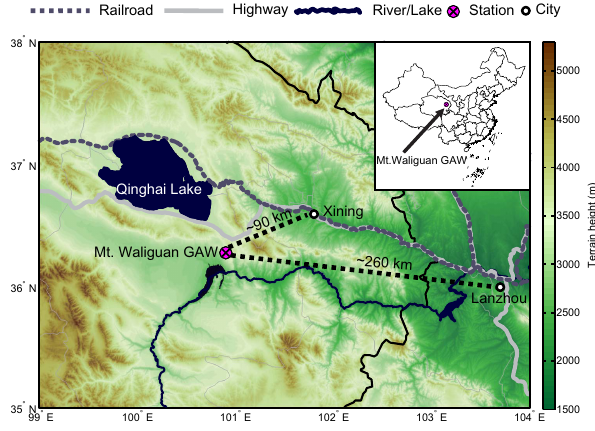
Figure 1. The location of the Mt Waliguan GAW site and the two major cities in its vicinity. The shading stands for the topographic